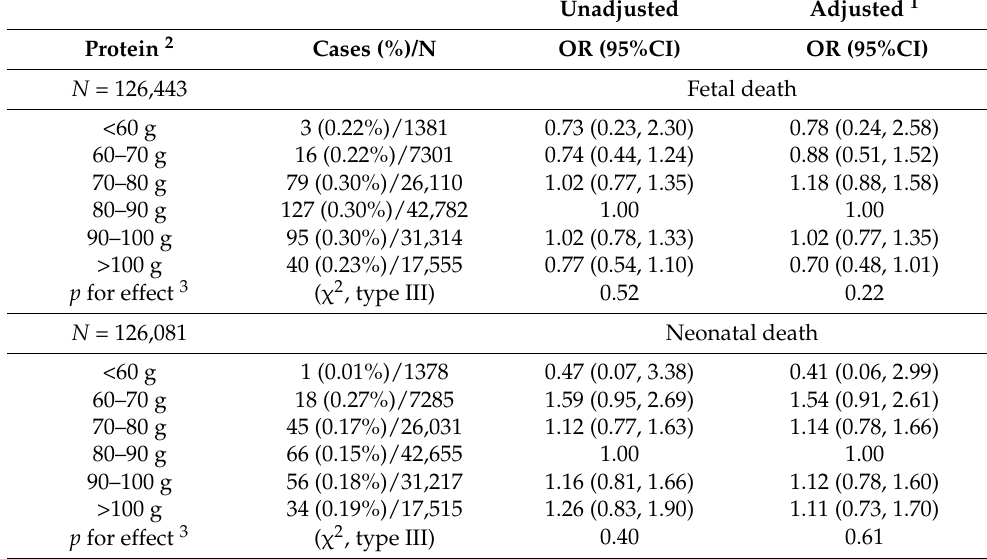
Table 6. Associations between maternal protein intake and risk of fetal and neonatal deaths. The associations are presented in terms of odds ratios (ORs) using the 80–90 g category as the reference. The Danish National Birth Cohort (DNBC, 1996–2002) and the Norwegian Mother, Father and Child Cohort study (MoBa,